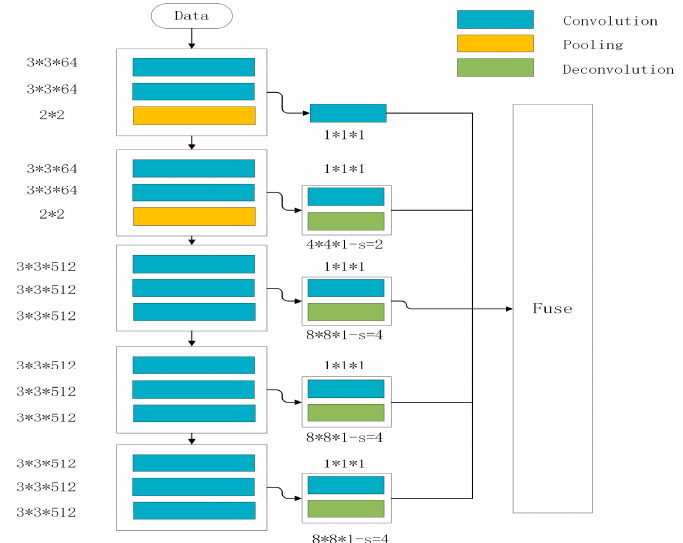
Figure 3. Improved HED network structure.